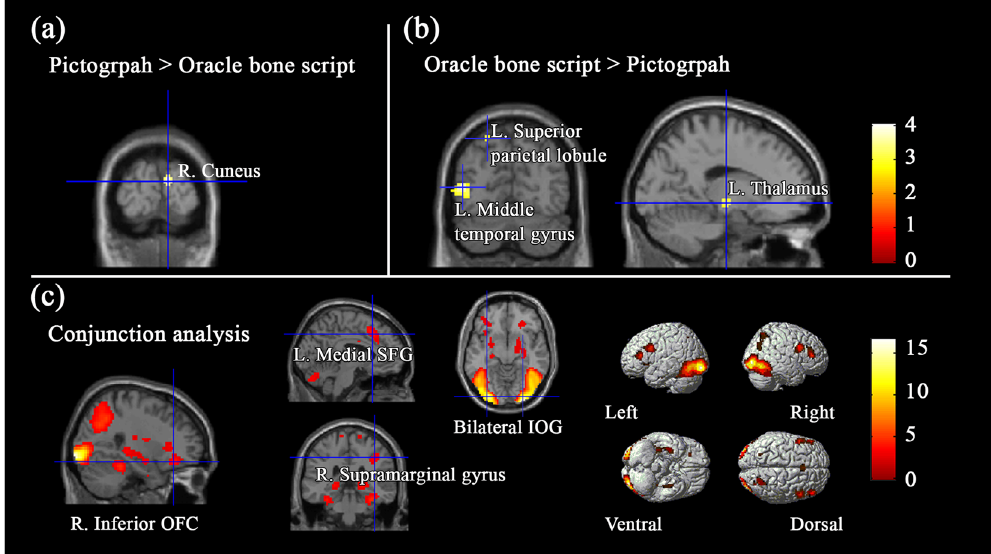
Figure 4. Cerebral areas for aesthetic judgments regardless of the aesthetic